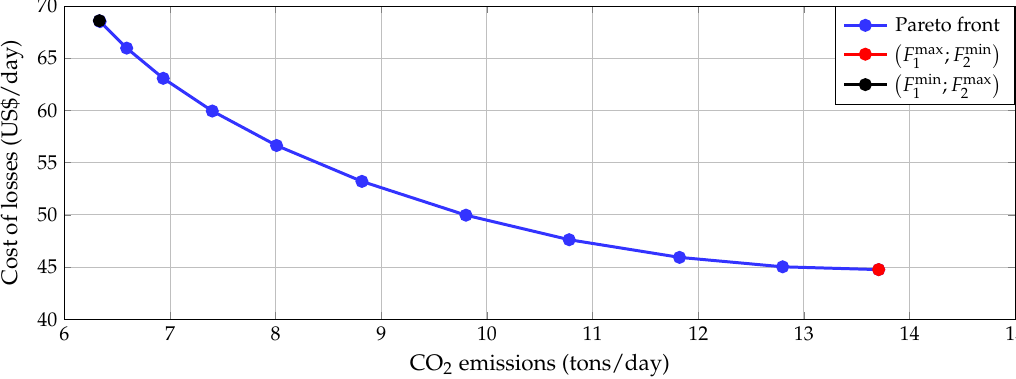
Figure 3. Pareto front for the BESS operation with variable power